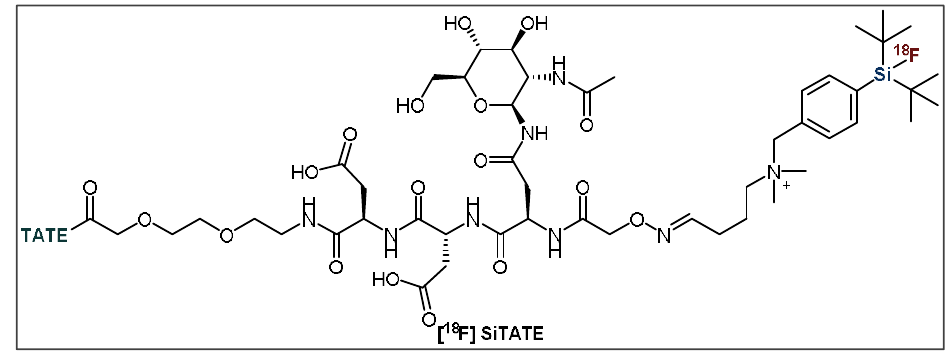
Figure 6. General structure of [ 18 F]SiTATE. TATE = Tyr 3 -octreotate. The refinement of [ 18 F]SiTATE was accomplished through analysis of various parameters, including SSTR-binding capabilities, lipophilicity and PET image quality [37,40]. These assessments in animal models revealed that the lipophilicity-reducing modifications successfully amended previous problems among SiFA peptides, as [ 18 F]SiTATE demonstrated limited liver accumulation, low background noise and higher tumor uptake, with a decrease in lipophilicity when compared to [ 18 F]SiFA-TATE [40]. Additionally, a study comparing the effectiveness of [ 18 F]SiTATE to [ 68 Ga]Ga-DOTA-TATE in mice showed similar biodistribution profiles yet superior tumor uptake for [ 18 F]SiTATE (18.51% ± 4.89% vs. 14.10% ± 4.84% ID/g, respectively) (Figure 7) [37]. These results indicate that this tracer could be an ideal candidate for future clinical studies.